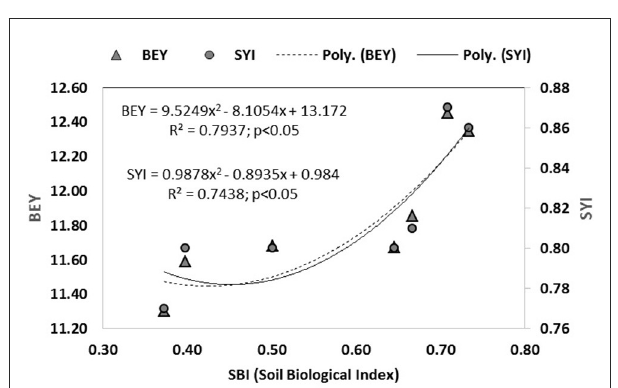
FIGURE6 Relationship between soil biological index (SBI) with system productivity (BEY) and sustainable yield index (SYI) under tillage and residue management